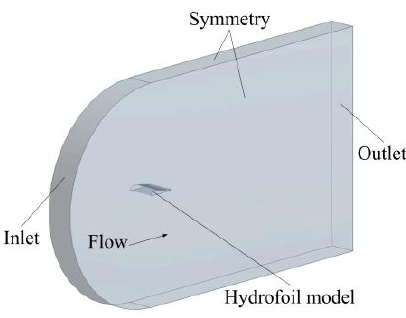
Figure 5. Schematic of the computational domain and boundary conditions.